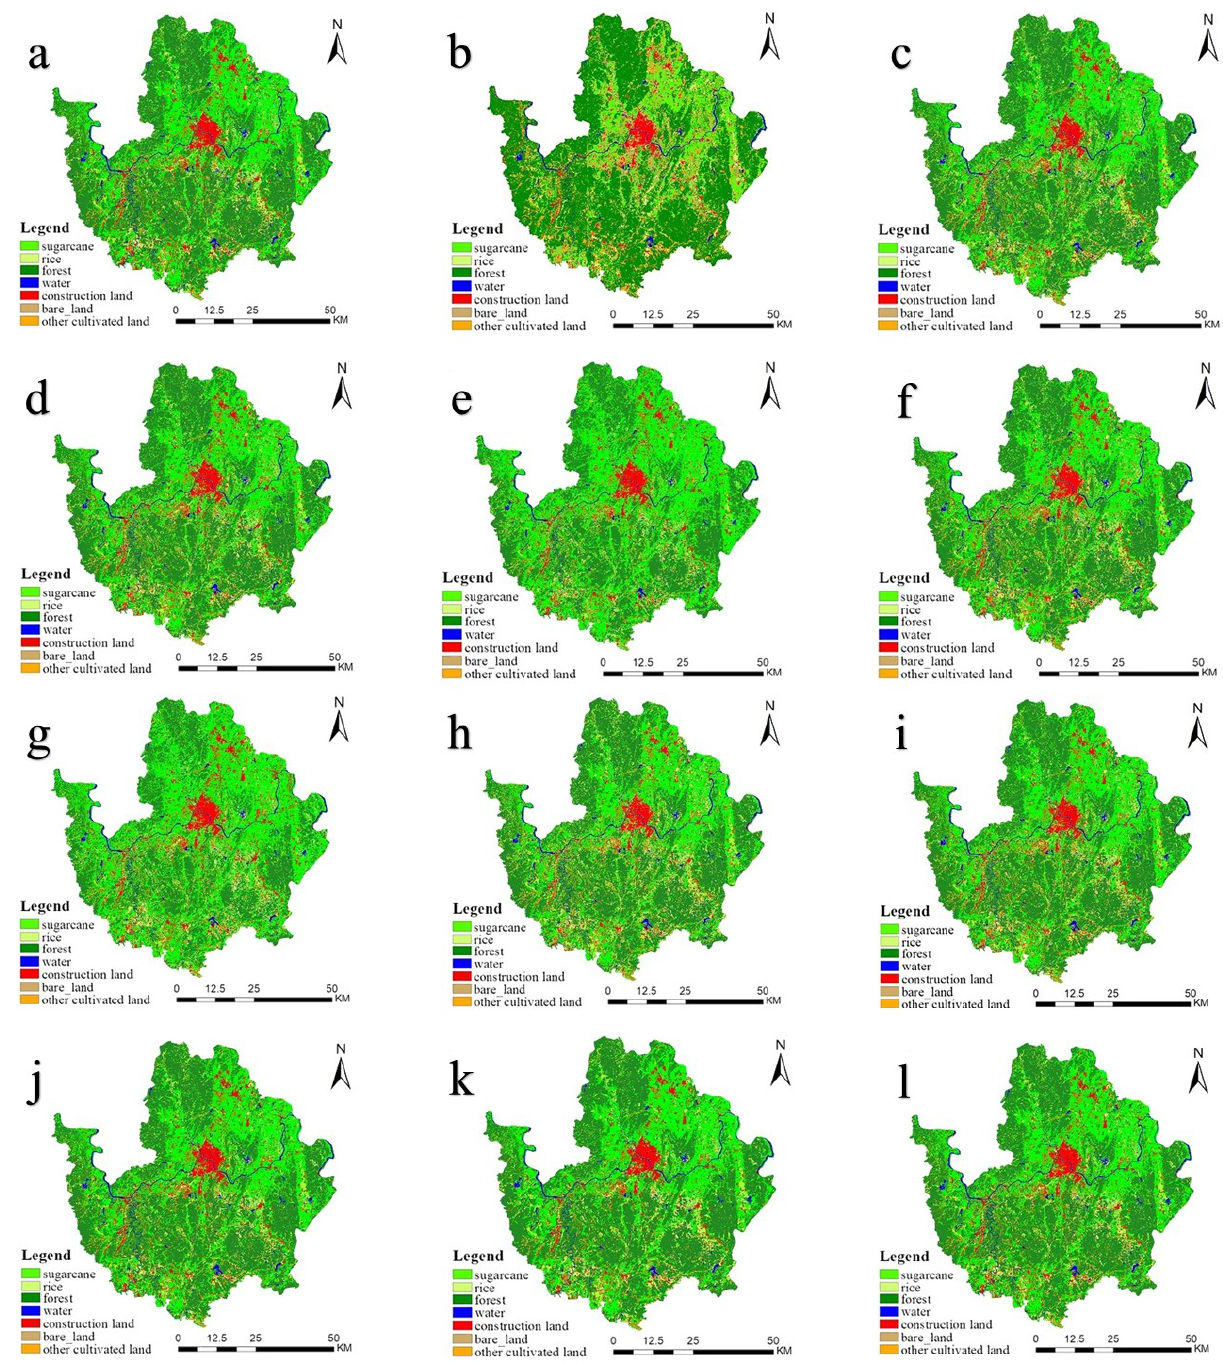
Figure 4. Comparison of remote sensing image classification results of the study area by differ- ent methods, where ( a – l ) are, in order, the ground truth category, Sentinel-2A, CAM-UNet+SVM, U-Net, SegNet, Attention-UNet, SAR-UNet, UNet+SVM, Res-UNet+SVM, Deeplabve3+Resnet50, Deeplabve3+Xception, and